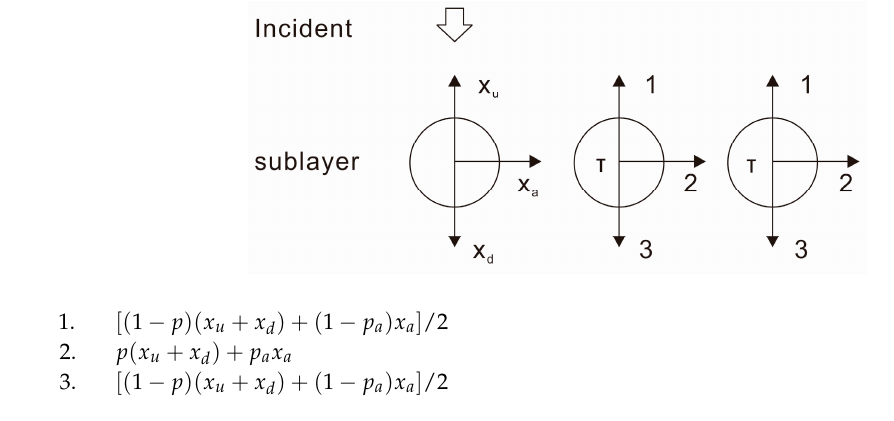
Figure 6. A schematic representation of sublayer backscattering and forward scattering with direction changes of particle scattering ratios taken into account. τ is the particle transmittance. x u , x a and x d represent the particle backscattering, lateral scattering and forward scattering ratios, respectively. p and p a are the directional change coefficients for x u ( x d ) and x a , respectively; their values have been given in Appendix A.